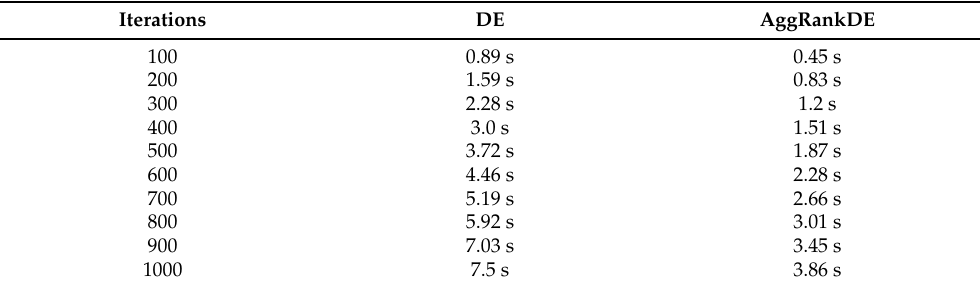
Table 10. The average time (in seconds) depending on the number of iterations. The remaining parameters are according to Table